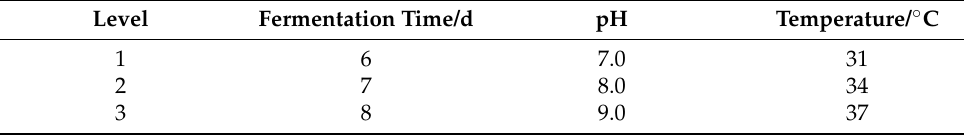
Table 1. Factors and levels of orthogonal